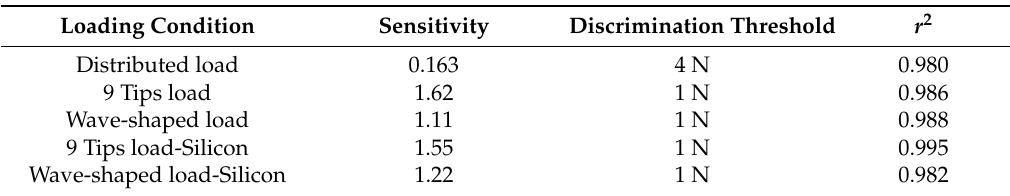
Table 1. Results obtained from the calibration curve for each loading condition, considering the sensor S2004–060.